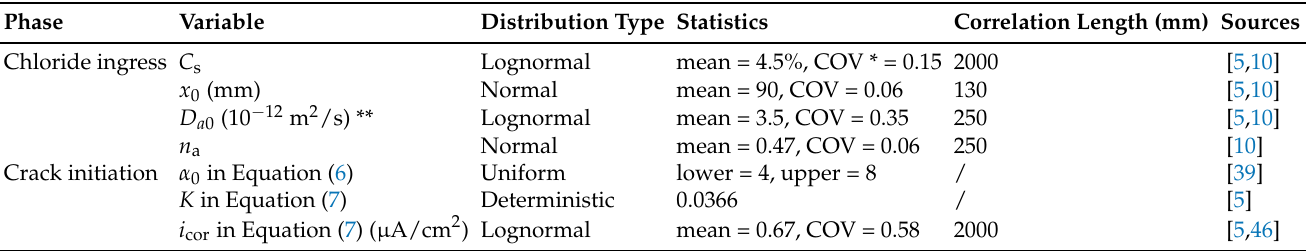
Table 2. Statistical information of the durability